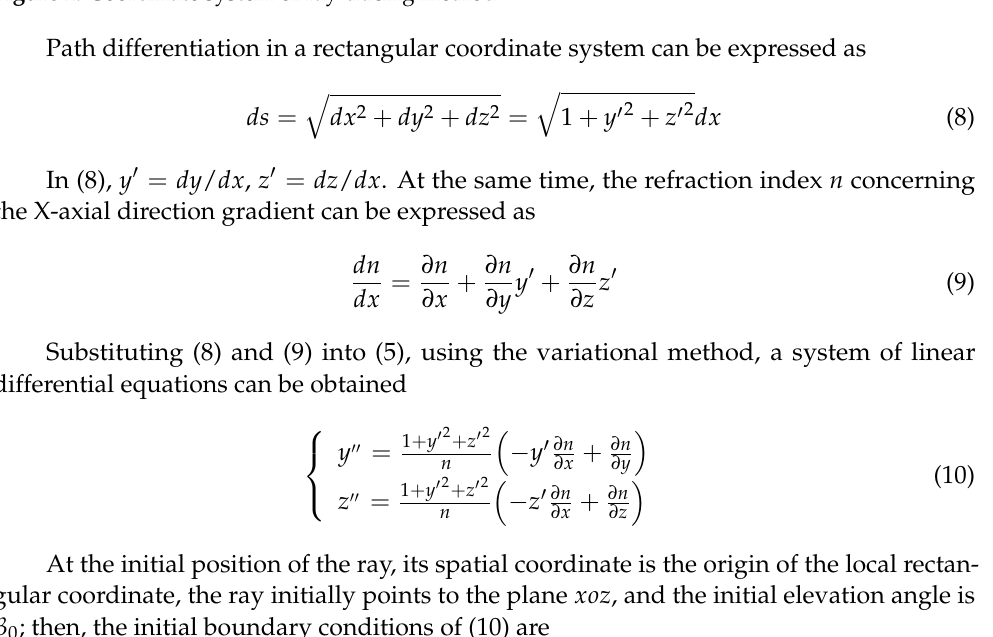
Figure 2. Coordinate system of ray-tracing method.